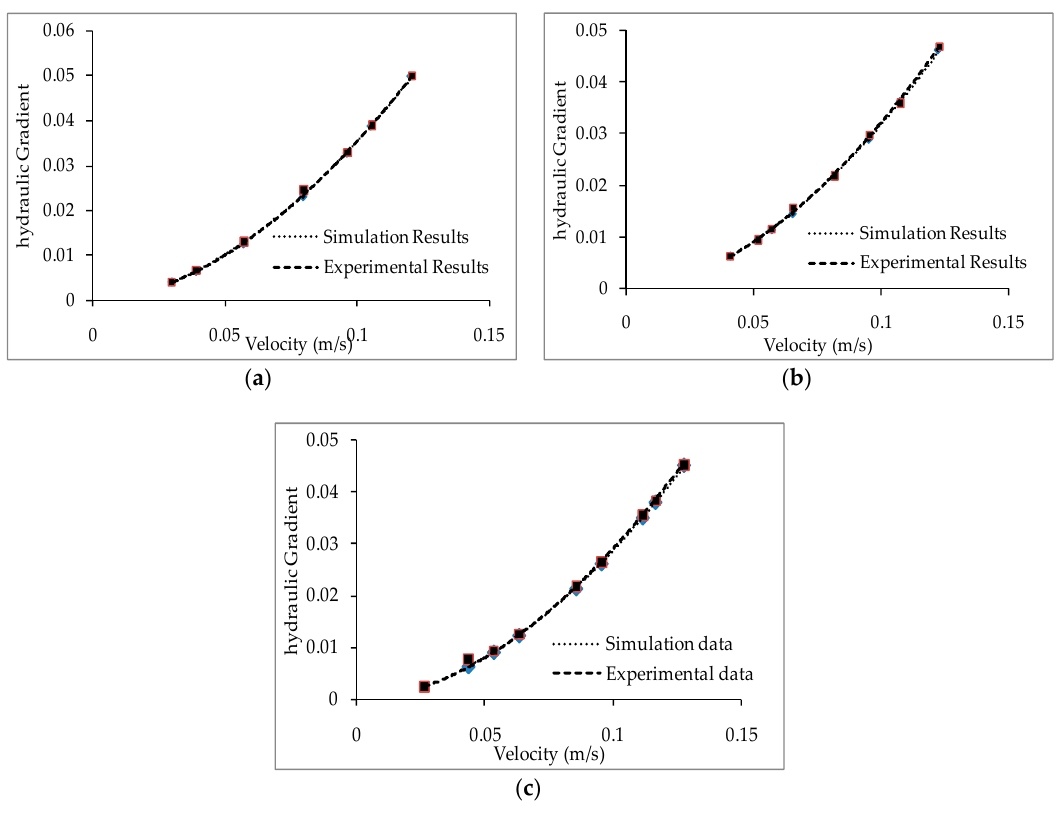
Figure 11. Comparison of simulation and experimental results for 41.59 mm media packed with ( a ) 41.03%; ( b ) 43.62%; and ( c ) 46.15% porosities.